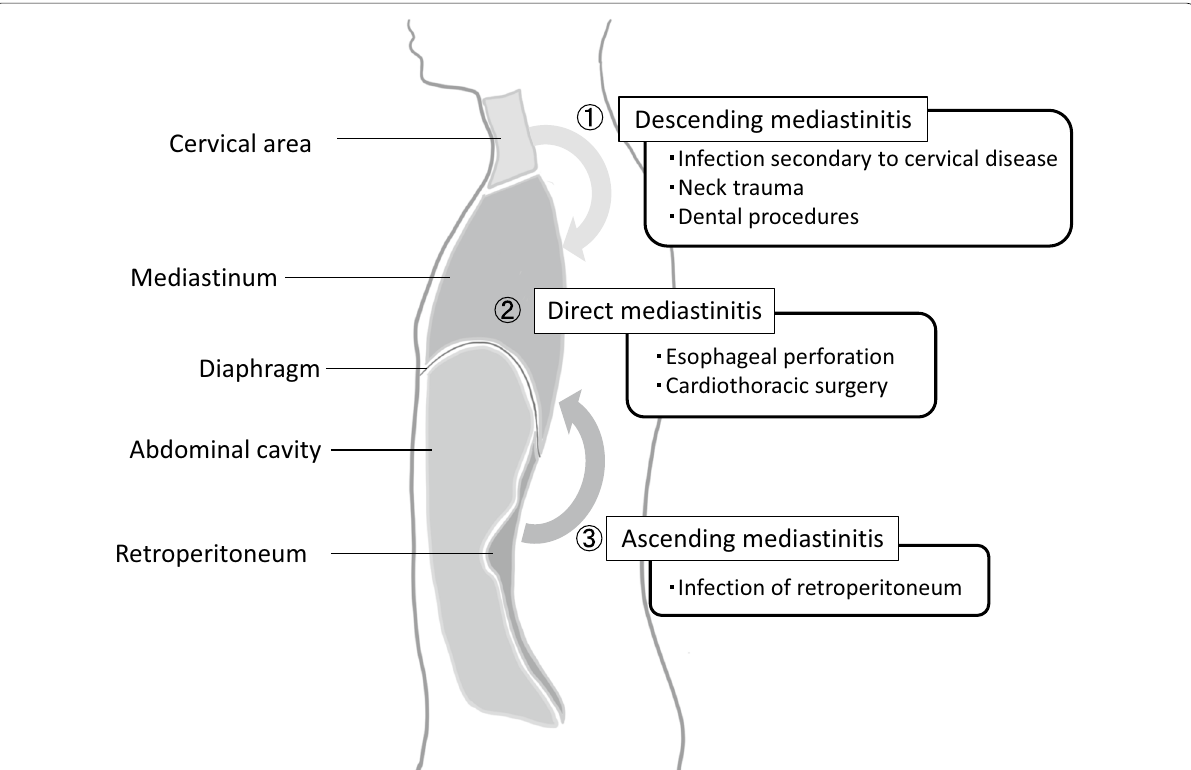
Fig. 1 Causes of mediastinitis. Mediastinitis can be divided into three types, descending, direct, and ascending mediastinitis, according to the location of the infection and the way the infection